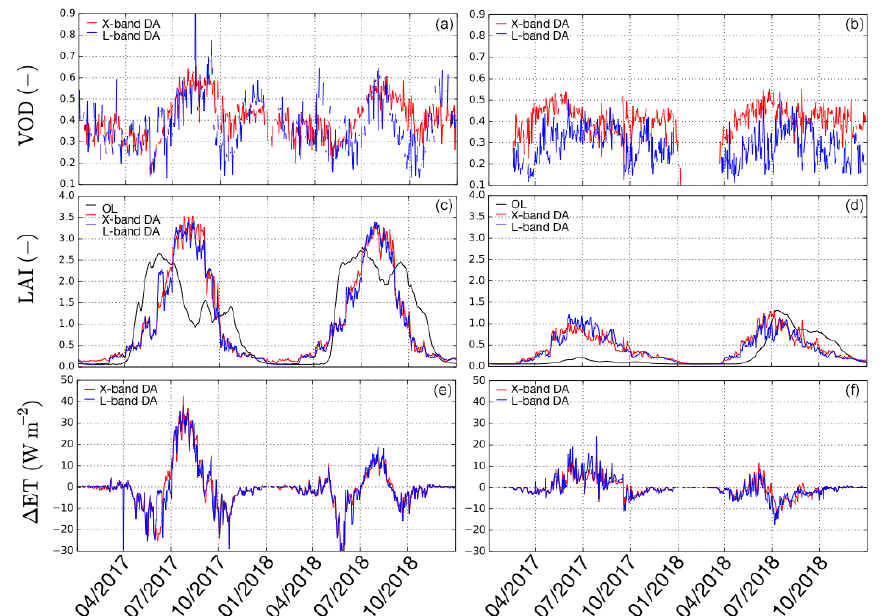
Figure 7. Time series of VOD (a, b) , LAI (c, d) , and changes in evapotranspiration relative to the OL (e, f) , for years 2017 and 2018, averaged over a cropland (location A in Fig. 1) and woodland (location B in Fig. 1) area. The left- and the right-hand side columns represent locations A and B,